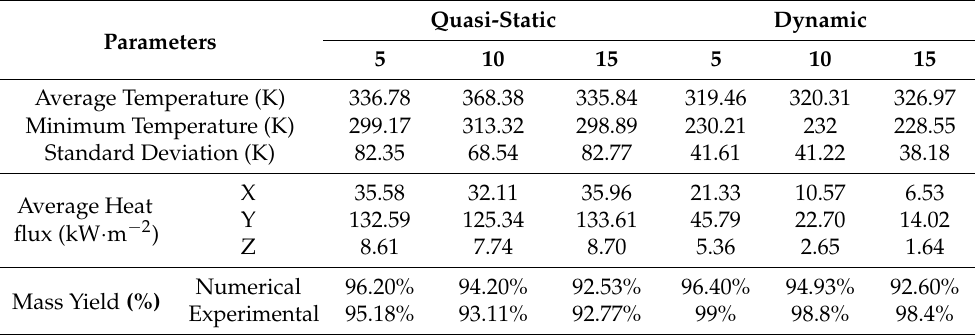
Figure 11. The average temperature distribution across a biofuel pellet in both quasi-static and dynamic thermal conditions under varying heat flux conditions. Table 5. The numerical solution derived from a PDE model under the experimental conditions of a Joule heating